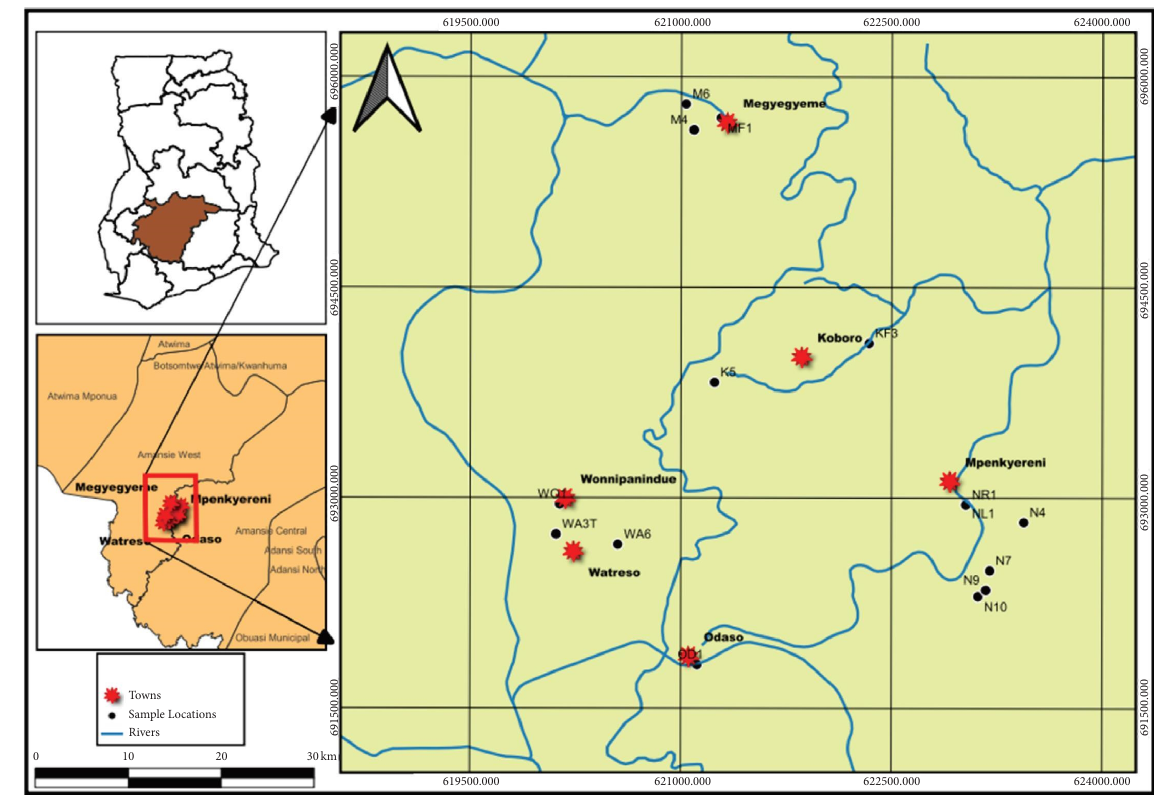
Figure 1: A map of the towns from which the samples were